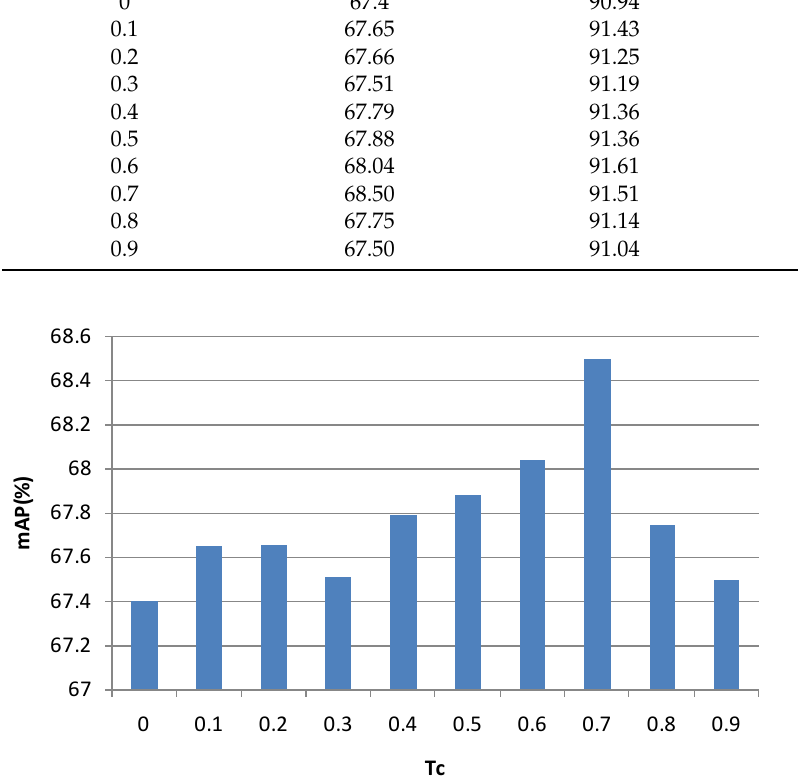
Figure 12. mAP of models under different T c